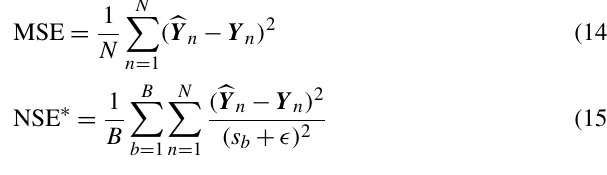
Mean daily solid precipitation Static Mean daily potential evapotranspiration